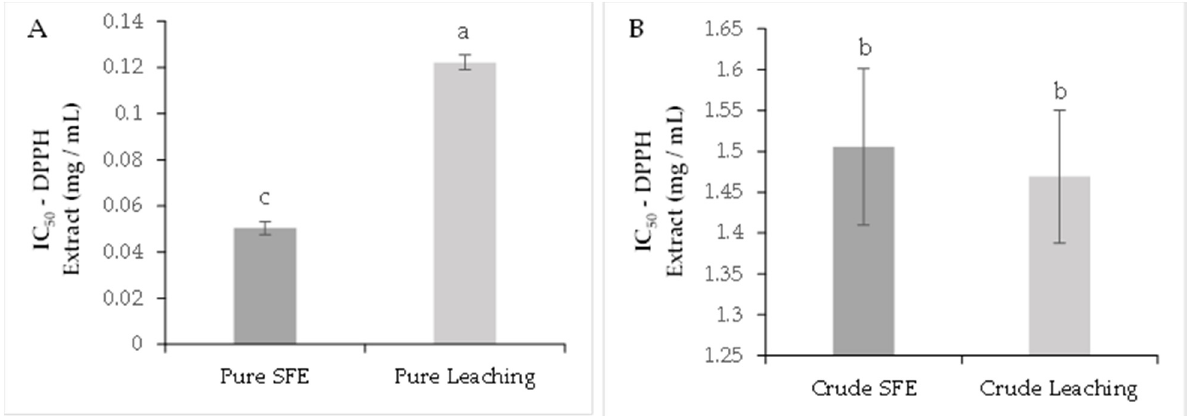
Figure 1. DPPH antioxidant capacity analysis. Purified extracts ( A ), crude extracts ( B ). The results are shown as mean ± standard error. Different letters indicate significant differences among treatments ( p < 0.05) (Tukey’s HSD post hoc analysis).